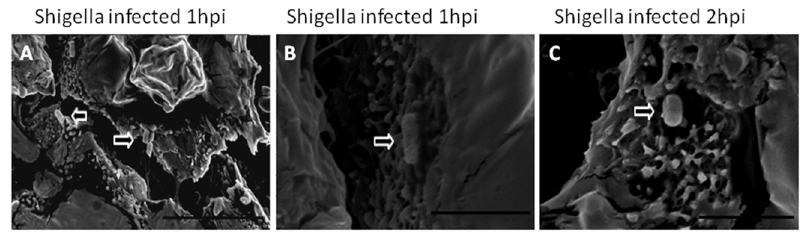
Figure 8. Scanning electron microscopy of the primary chicken intestinal epithelial cells infected with the Shigella strain ZD02. Uninternalized bacteria (arrowhead) were seen near the epithelial cells 1 h post-inoculation (A. Scale bar=10 m m). Bacteria (arrowheads) attached to the surfaces of the epithelial cells at 1 h (B. Scale bar=3 m m). Bacteria (arrowheads) were being internalized by the epithelial cells at 2 h (C. Scale bar=3 m